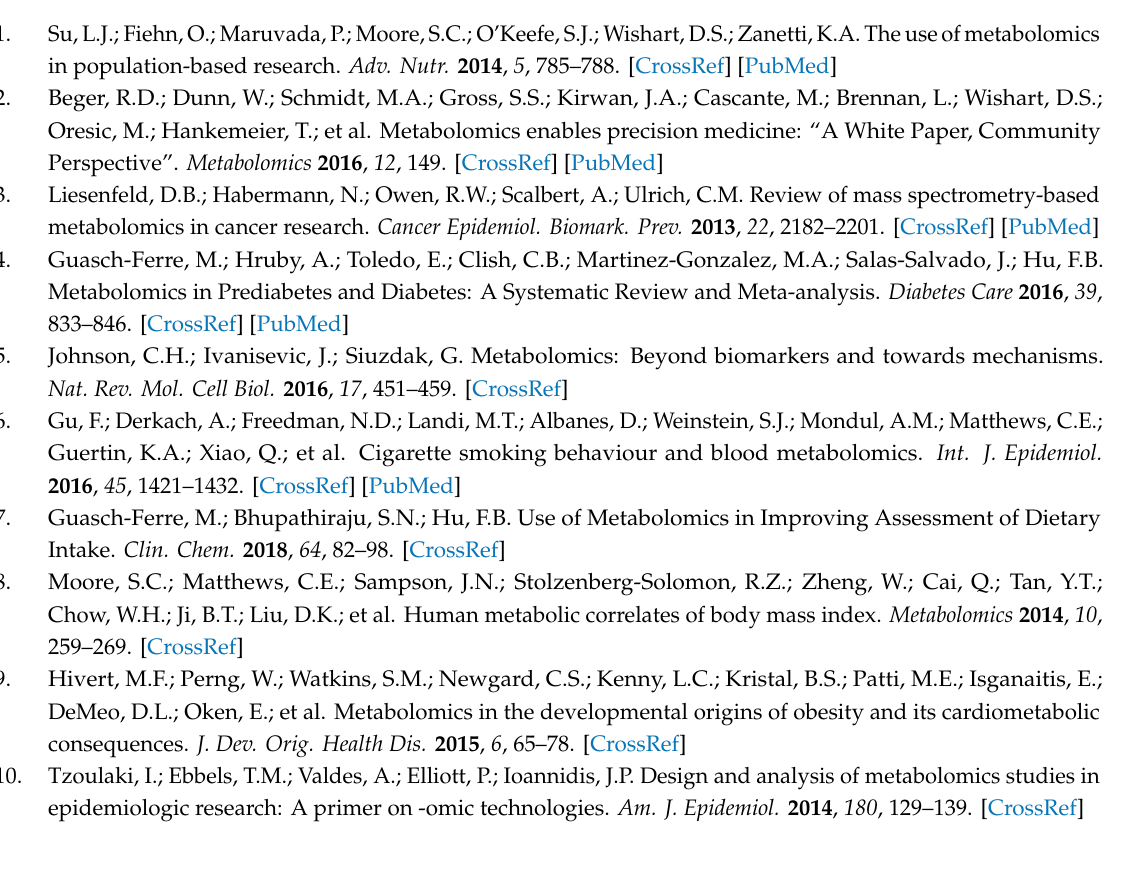
Table S1: Summary of Questionnaire Responses from COMETS Cohort Representatives (n =